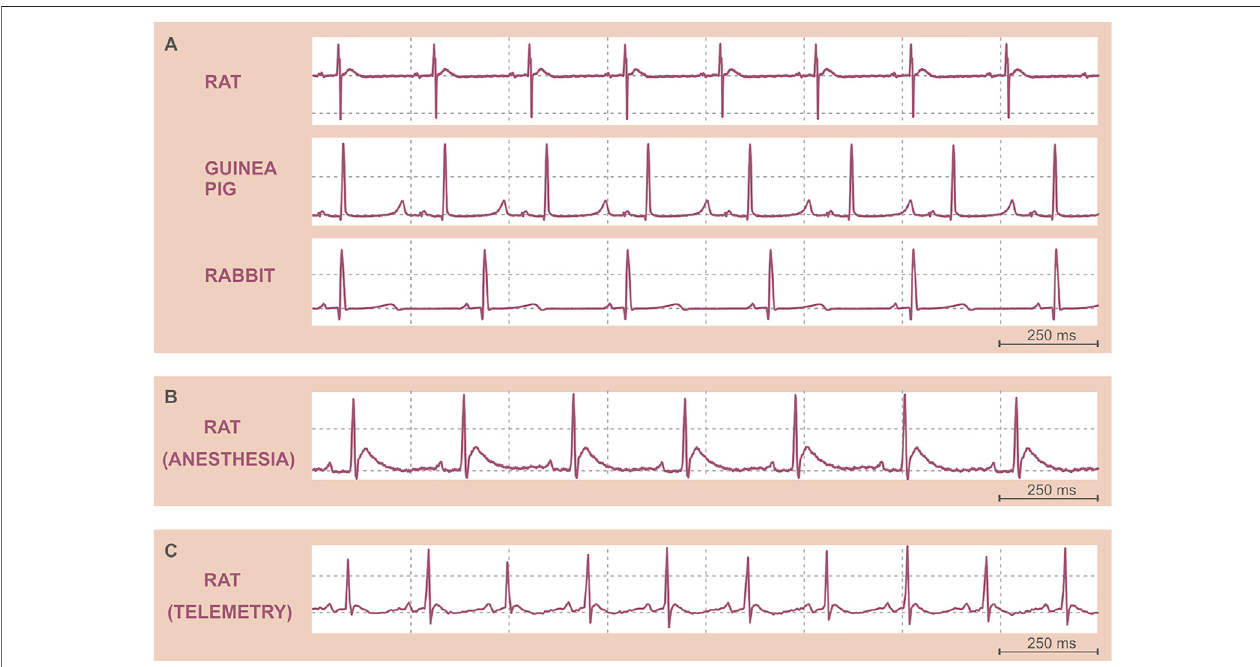
FIGURE 1 | Original ECG records. (A) Isolated heart electrograms of various species. (B) ECG in an anesthetized Sprague Dawley male rat recorded by needle electrodes. (C) ECGinafreelymovingWistarmaleratrecordedbytelemetry.Notethedifferencesintheheartrateamongspecies (A) andbetweenanesthetized (B) and conscious (C)